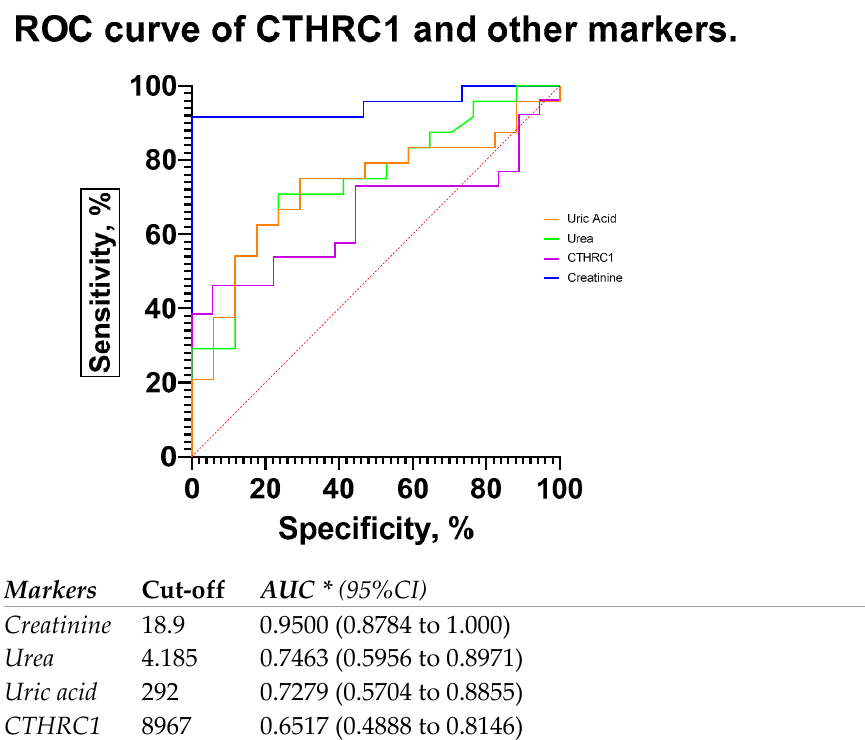
Figure 5. ROC curve and AUC for CTHRC1 levels and other markers in patients with eGFR rates below 60 mL/min/1.73 m 2 (eGFR < 60) and above 60 mL/min/1.73 m 2 (eGFR > 60). Cut-off values were defined as the value whose sensitivity and specificity are the closest to the value of the area under the ROC curve. * Area under ROC curve lies with 95% confidence